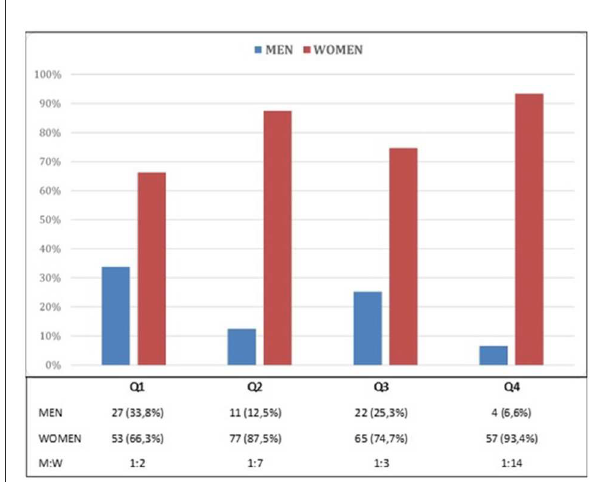
FIGURE2 Men/women ratio by quartile.